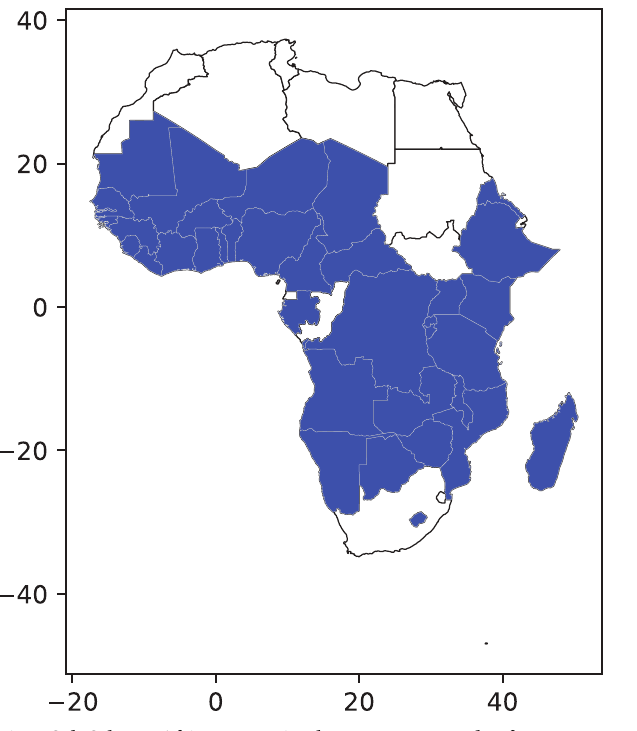
Fig 5. Sub-Saharan African countries that were aggregated to form a representative